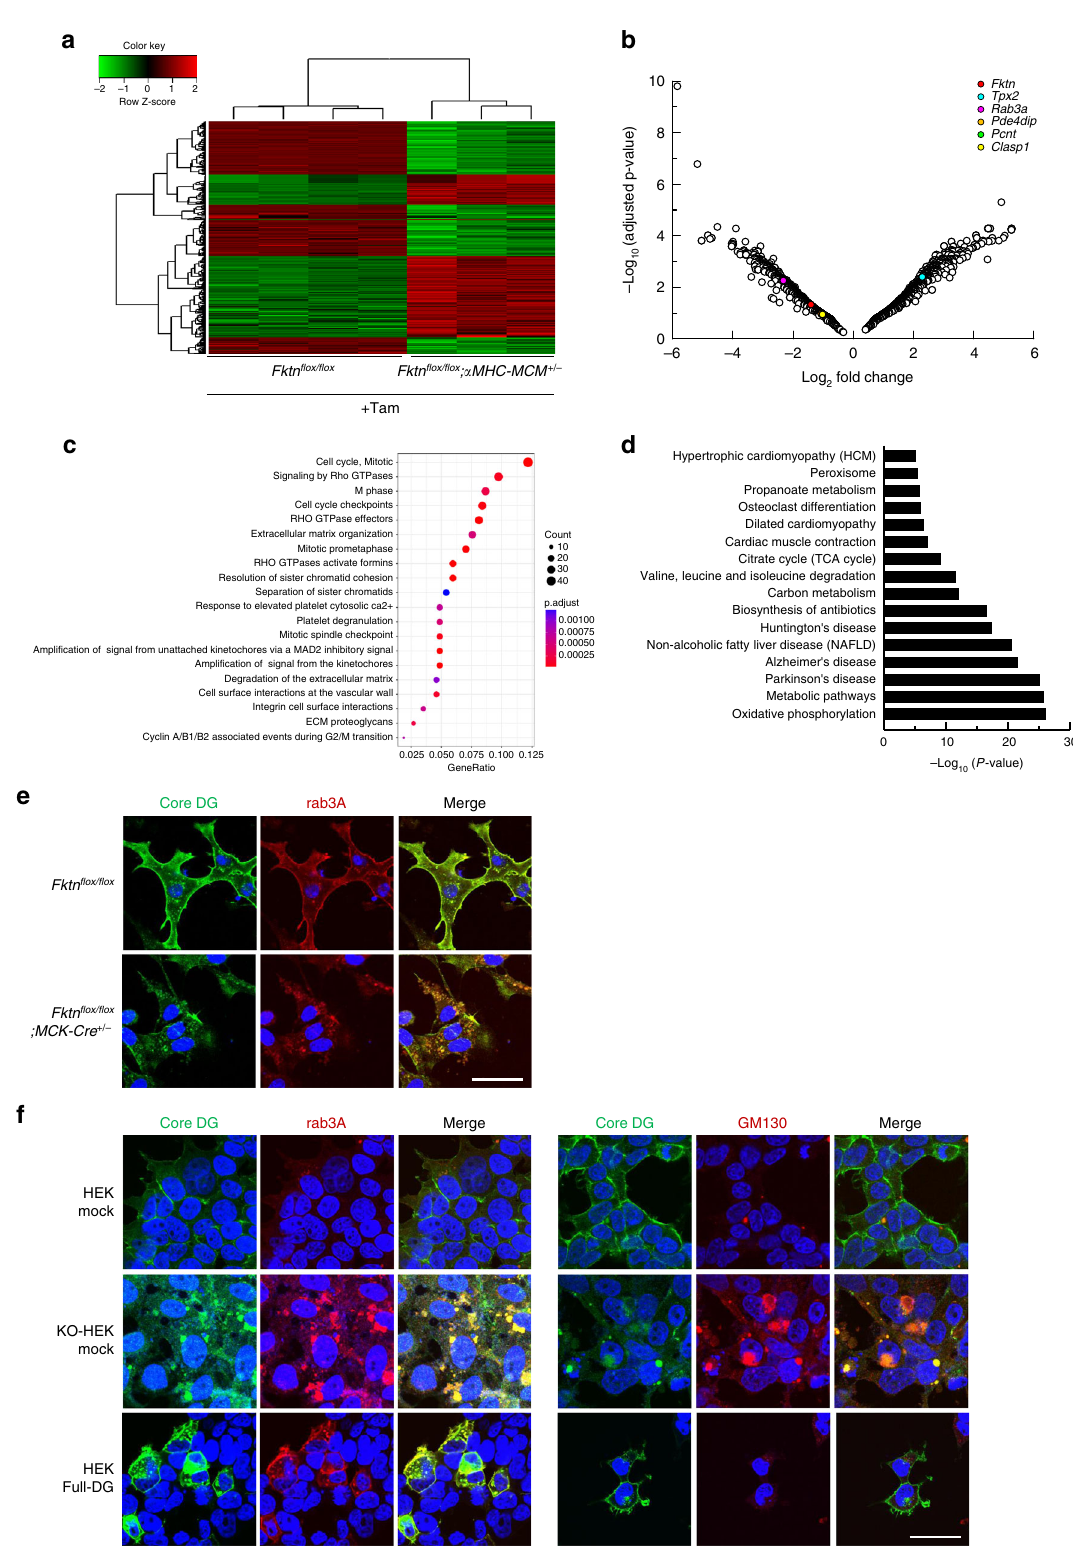
increased ef fl ux by NCX1 or SERCA (Supplementary Fig. 13), proteins that play important roles in Ca 2 + homeostasis and Ca 2 + handling during E – C coupling 27,49,50 . These alterations indicate that reserved capacity in responses to cardiomyocytes stress was impaired without causing signi fi cant cardiac dysfunction. Chronic isoproterenol treatment in these mice